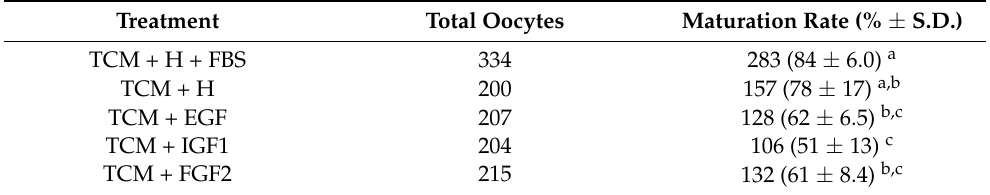
Table 1. Effect of removing fetal bovine serum and/or hormones from TCM-199-based medium on the in vitro maturation of bovine oocytes.